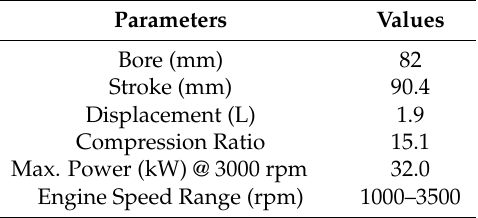
Table 2. Specification of GM Z19DTH diesel engine converted for RCCI operation [40].